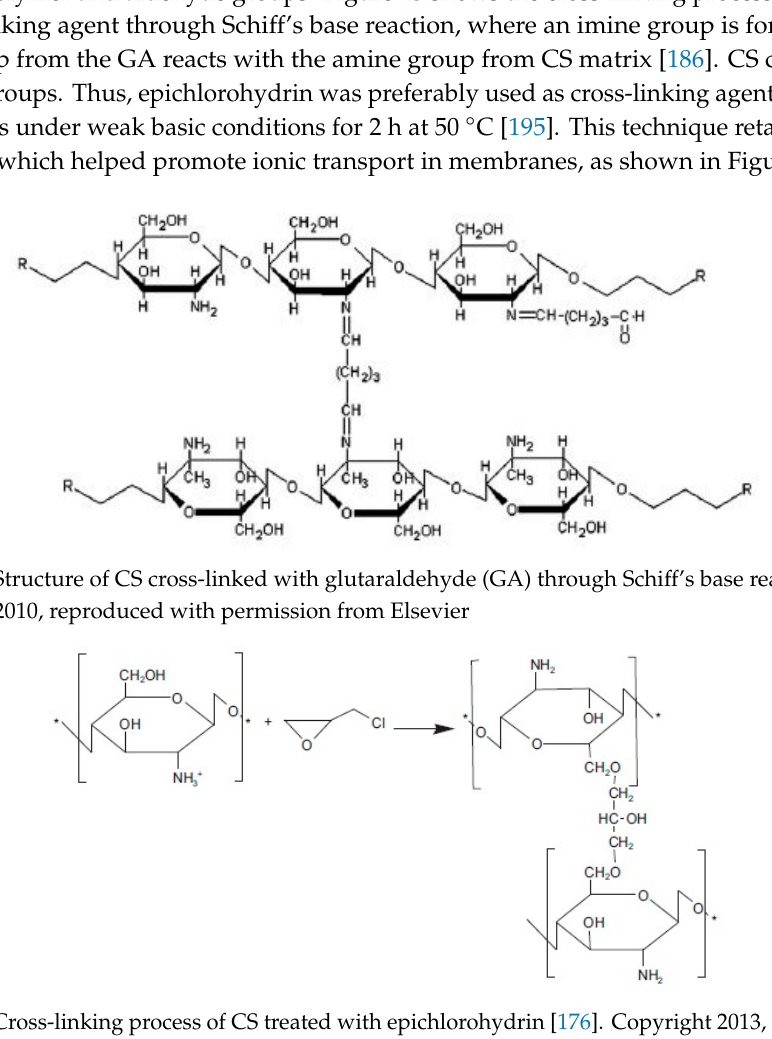
Figure 16. Cross-linking process of CS treated with epichlorohydrin [176]. Copyright 2013, reproduced with permission from Elsevier